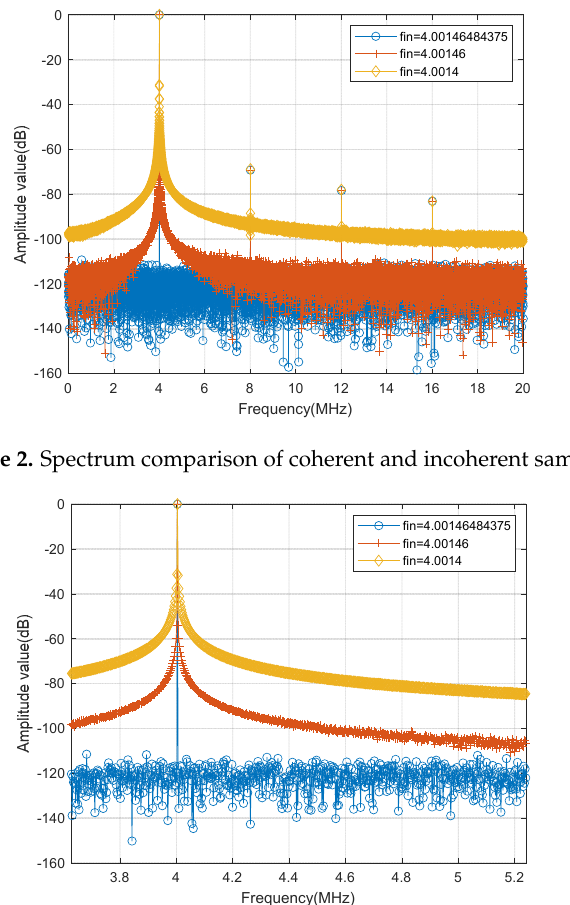
Figure 3. Local amplification of spectral comparison graphs for coherent and incoherent sampling.